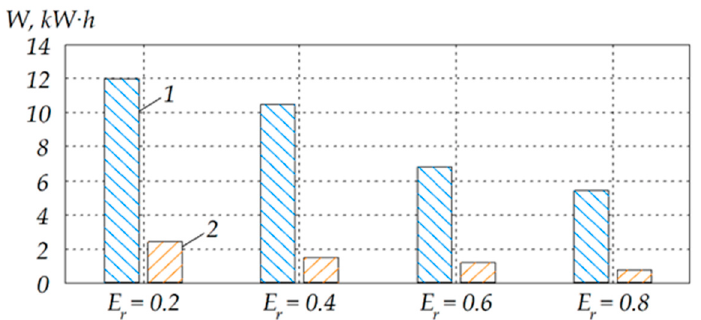
Figure 6. The dependence of the energy consumption W of the furnace in the manufacture of ceramic filters on relative indicator E r : 1—aluminum oxide without additives; 2—aluminum oxide with metal oxide additives.